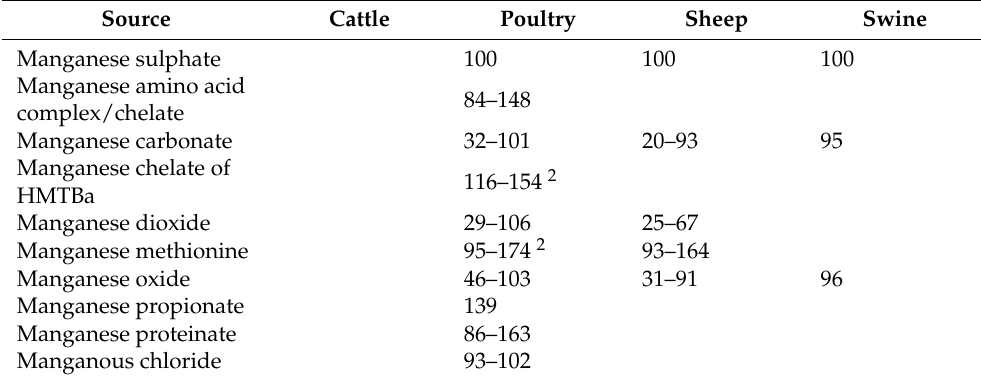
Table 6. Multi-species table of relative bioavailability values (%) for manganese 1,3